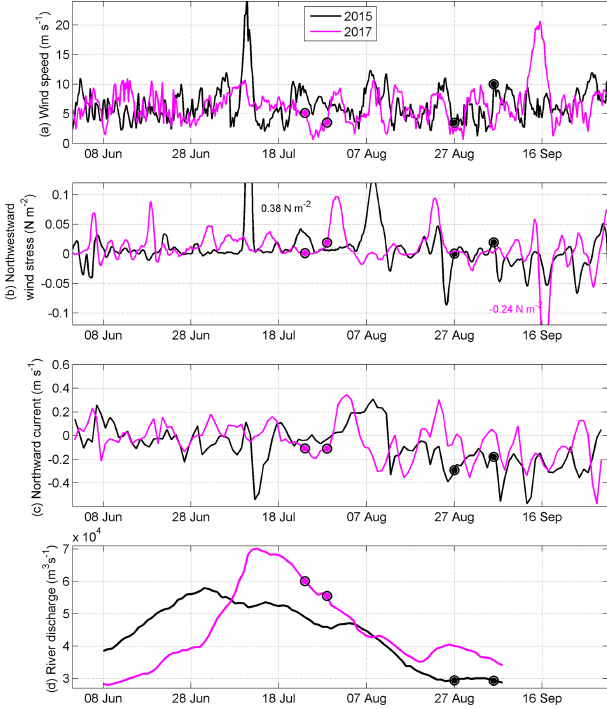
Figure 10. Time series of wind, current and river discharge. Mean wind speed (6h) (a) , 1d running mean SE–NW wind stress τ c (posi- tive towards NW; Nm − 2 ) (b) , daily mean meridional current veloc- ity component v m (positive northward) at section S1 (c) , and daily Changjiang River discharge at Datong station shifted by 7d to rep- resent flow in the river mouth (d) . Dots represent the start and end of the CTD surveys, respectively in 2015 and